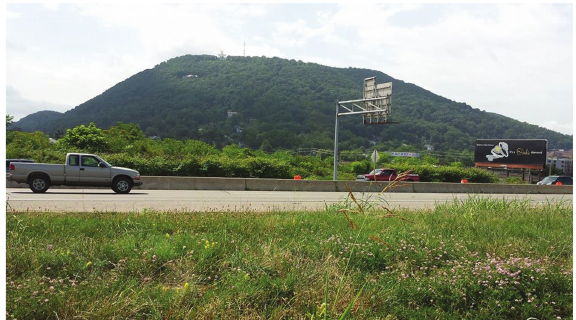
Figure 2: The base of Mill Mountain in southeastern